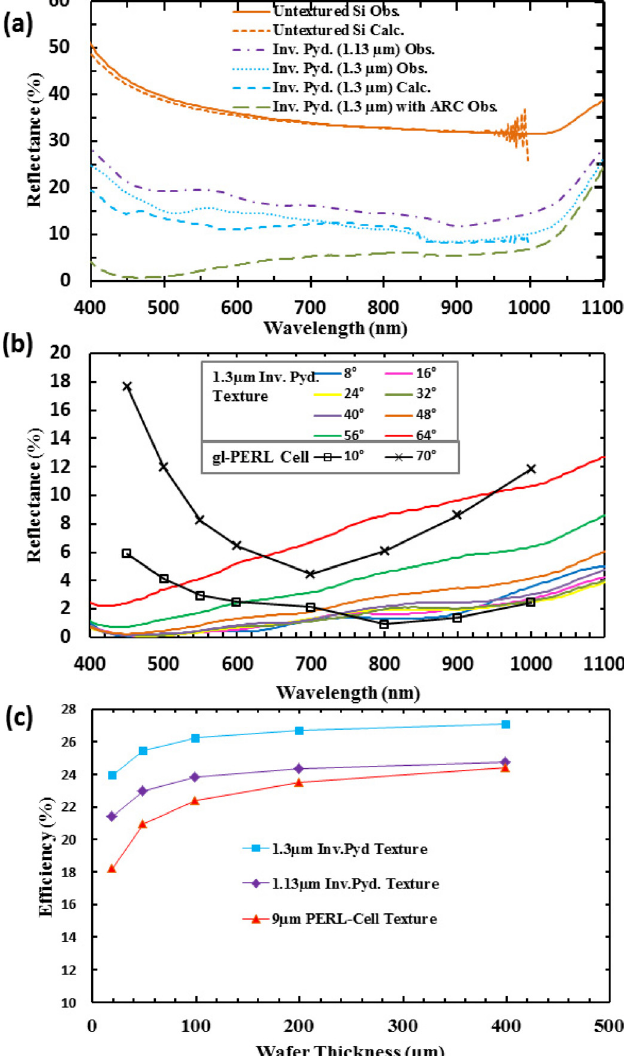
Fig. 4. (a) Experimental (solid lines) and simulated (dashed lines) total reflectance spectra at normal incidence from fab- ricated samples (1.13 μ m and 1.3 μ m inverted-pyramids) and bare silicon as a function of wavelength. (b) Measured specu- lar reflectance spectra from 1.3 μ m inverted pyramid texture coated with a 70 nm thick SiN x ARC and from a grid-less PERL-cell with dual layer ARC [19] for the various incidence angles shown. (c) Predicted efficiency of a solar cell with the presently fabricated (1.13 and 1.3 μ m inverted-pyramid) and the PERL-cell textures at various wafer thicknesses. A 70 nm thick PECVD deposited SiN x ARC is considered in efficiency